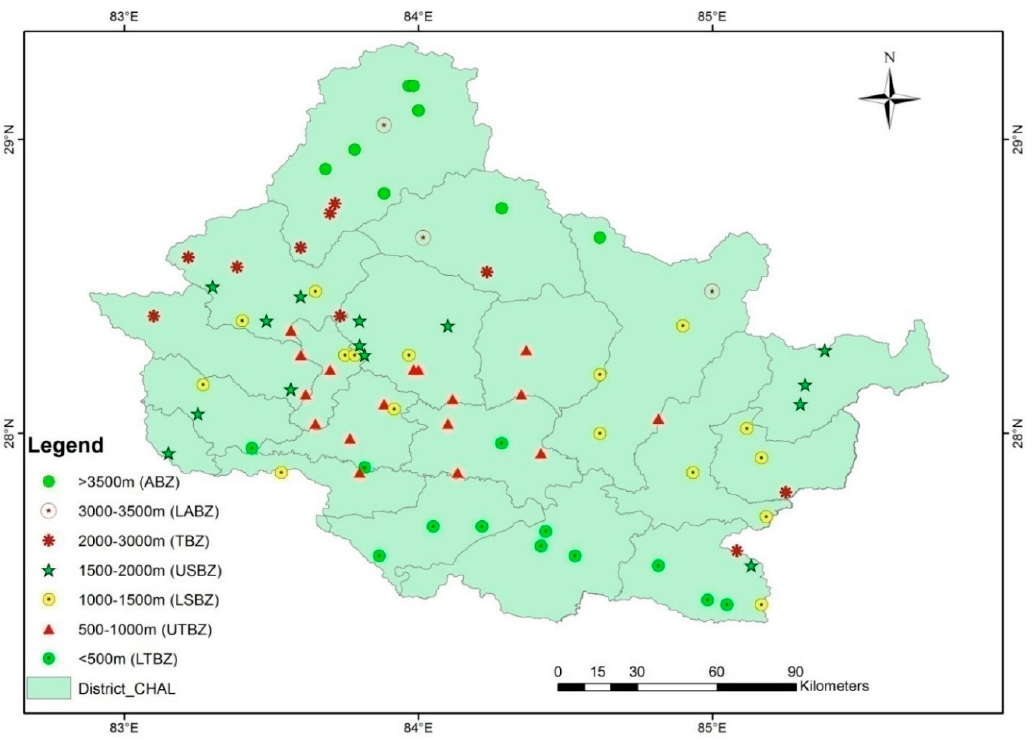
Figure 2. Stations recording precipitation at different bioclimatic zones in CHAL.